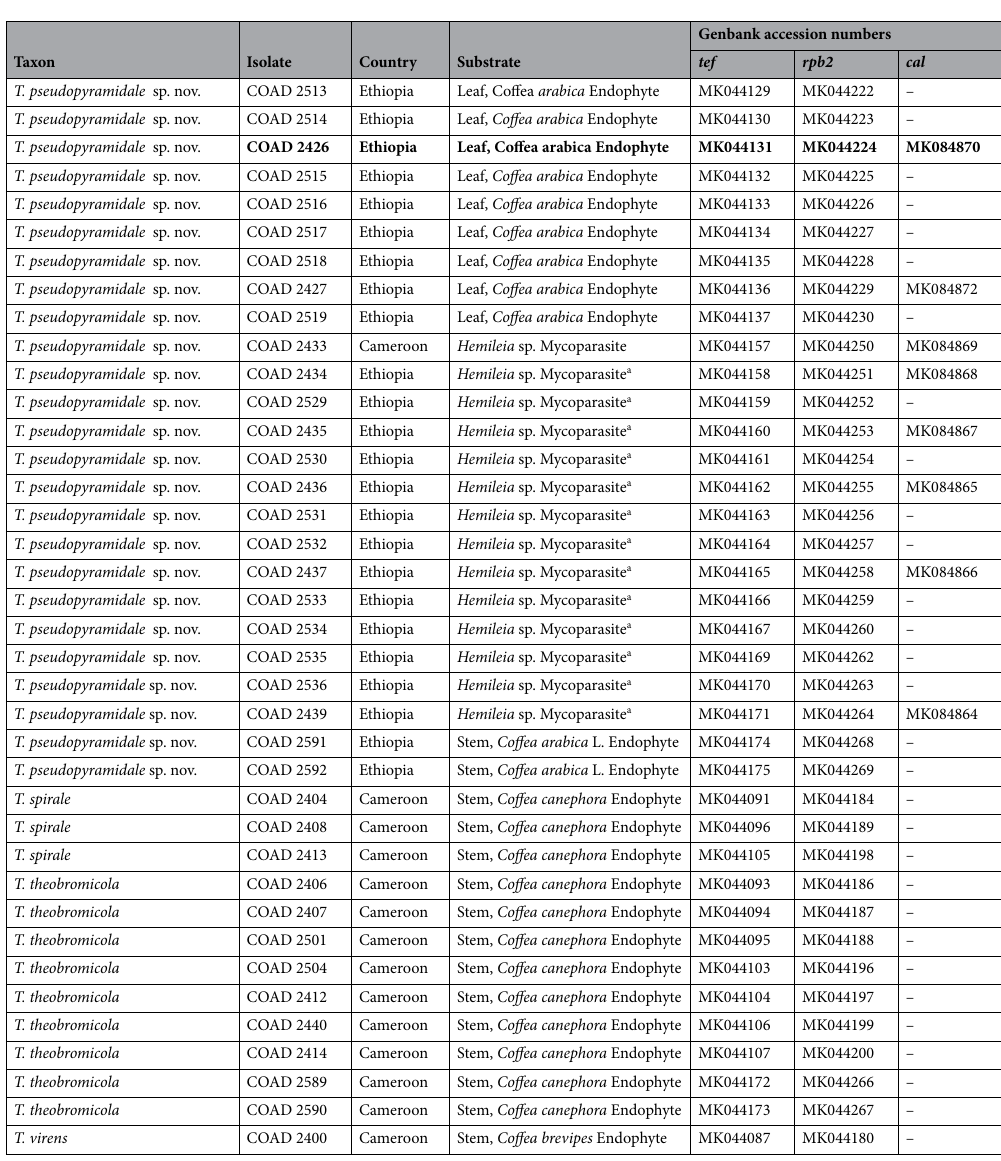
Table 1. Trichoderma strains obtained in the survey and used in the phylogenetic analyses, with their corresponding geographic origin, host and tissue source. Trichoderma strains isolated during this study. Ex-type strains are indicated in bold. a Close to H . coffeicola , but currently being assessed as a new species of Hemileia (Authors, unpublished). b Identified as a wild and geographically-isolated population of Coffea arabica , common in the understorey forest 54 . Kew Herbarium (Herb K) records reflect uncertainty about its true identity; botanical specimens from present survey deposited in Herb